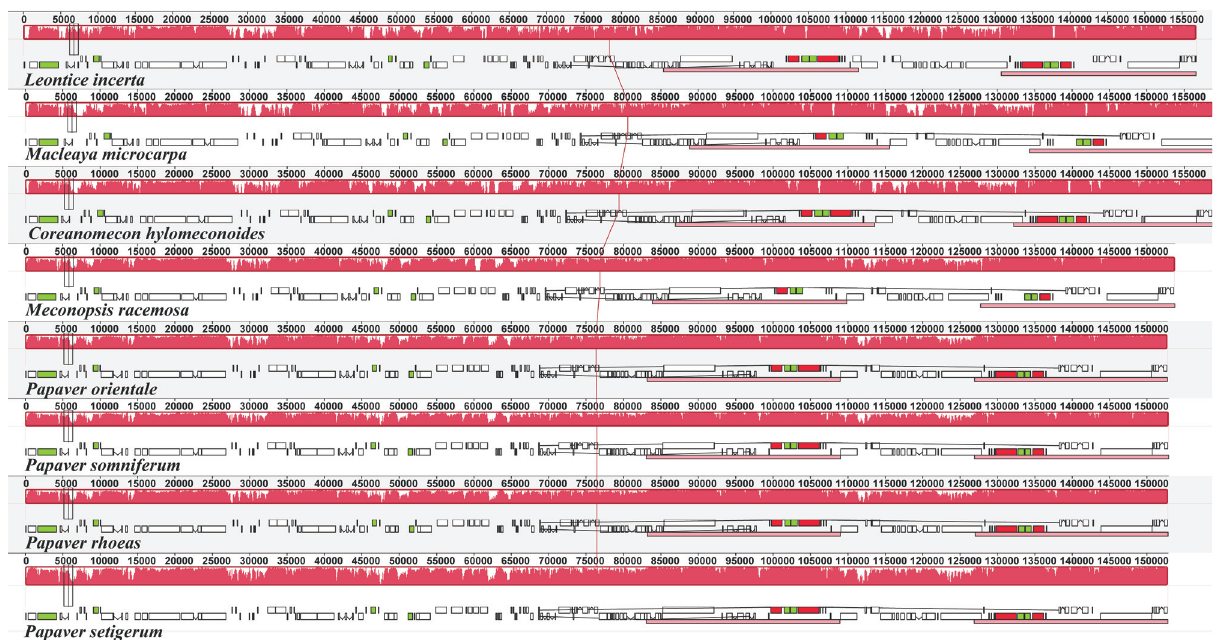
Figure 2 - Visualization of alignment of the seven Papaveraceae chloroplast genome sequences, with Leontice incerta as the reference. The horizontal axisindicatesthecoordinateswithinthechloroplastgenome.Theverticalscaleindicatesthepercentageofidentity,rangingfrom50to100%.Genomere- gions are color coded as protein coding, intron, mRNA, and conserved non-coding sequences (CNS).